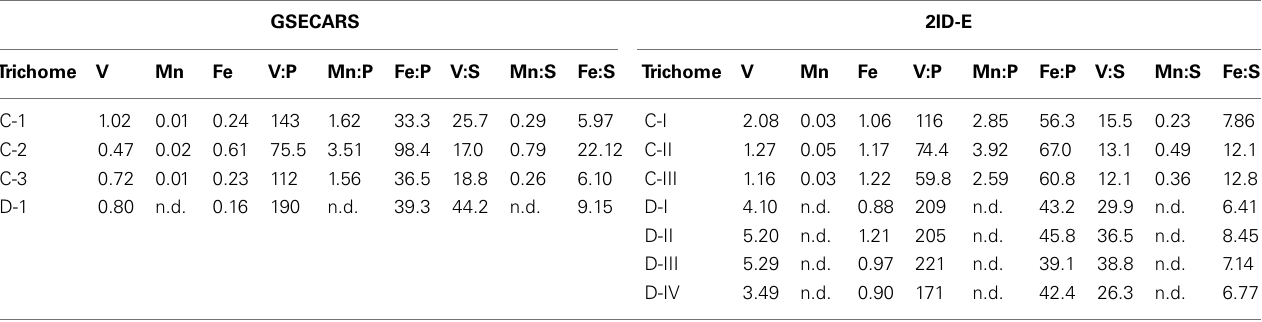
Table 4 | Comparison of areal element concentrations and P- and S-normalized stoichiometries forV, Mn, and Fe measured at GSECARS and